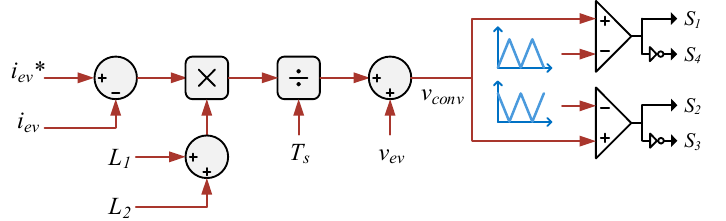
Figure 6. Current control scheme applied to the bidirectional multilevel dc–dc power converter.